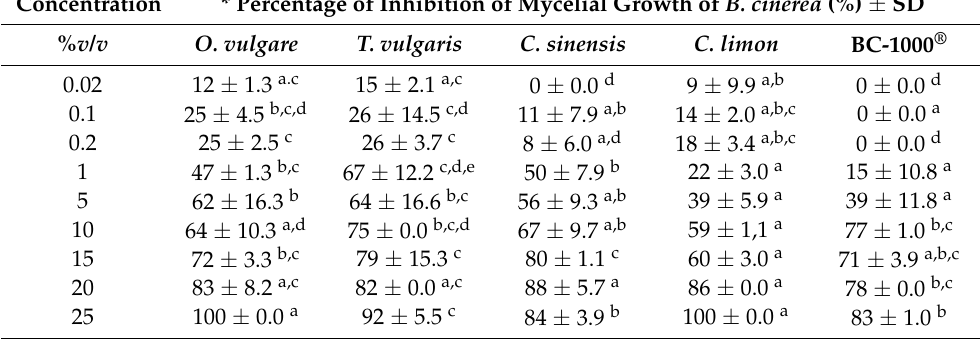
Table 2. Percentage of inhibition of B. cinerea mycelial growth induced by HYSs of T. vulgaris , O. vulgare , C. sinensis , and C. limon at different concentrations (% v / v ) three days after incubation. Concentration * Percentage of Inhibition of Mycelial Growth of B. cinerea (%) ± SD % v / v O. vulgare T. vulgaris